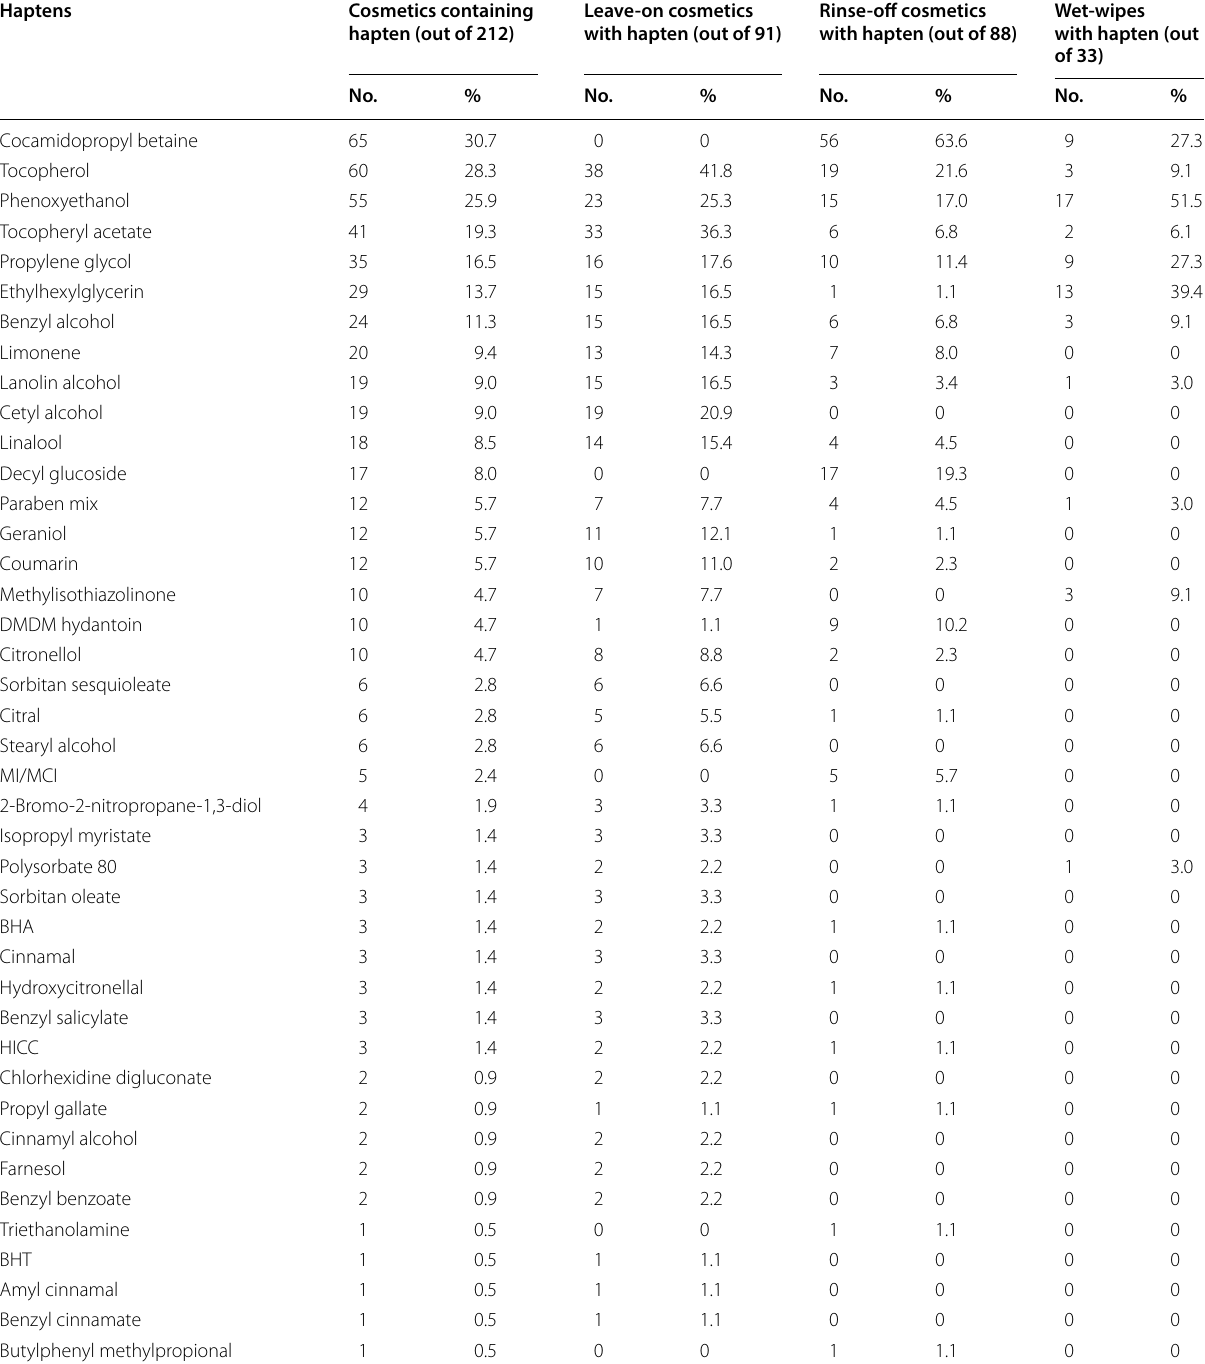
Table 1 Haptens in cosmetics for infants with numbers and percent of particular